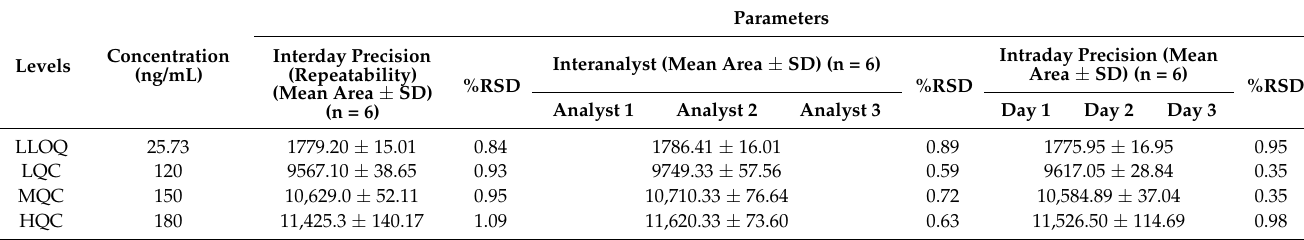
Table 3. Interday, intraday, interanalyst precision results for XH in